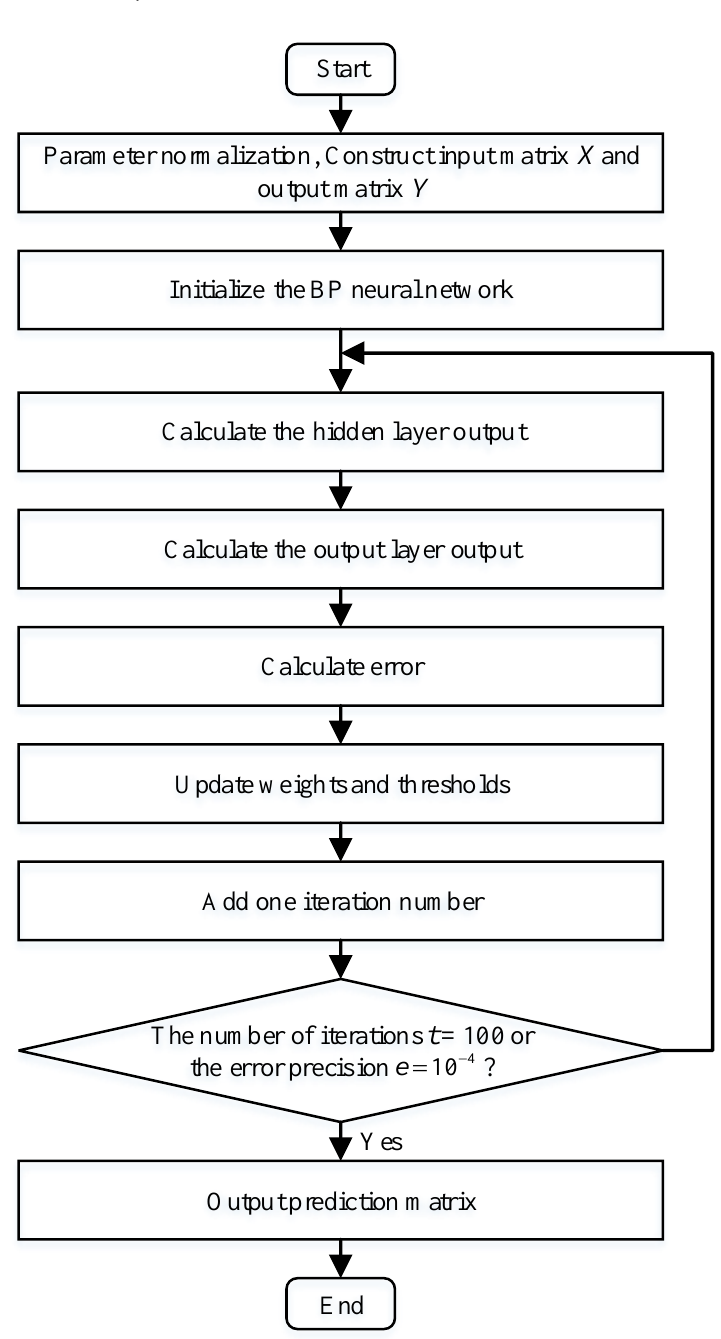
Figure 5. The flow of CEI based on BP neural network.